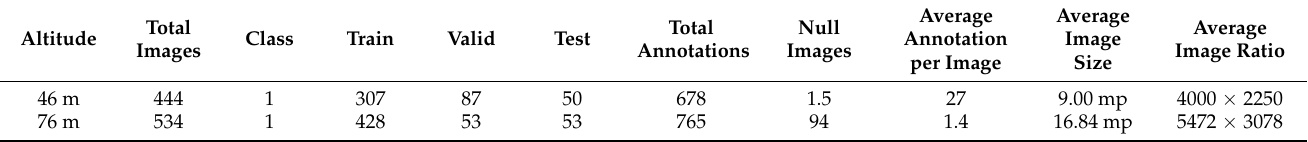
Table 2. Summary of both major groups of training sample photos collected at two altitudes (46 m and 76 m) at SHNF and CBC in spring 2022. After annotations were completed, images were split into training, validation, and test datasets for model development and performance assessment.